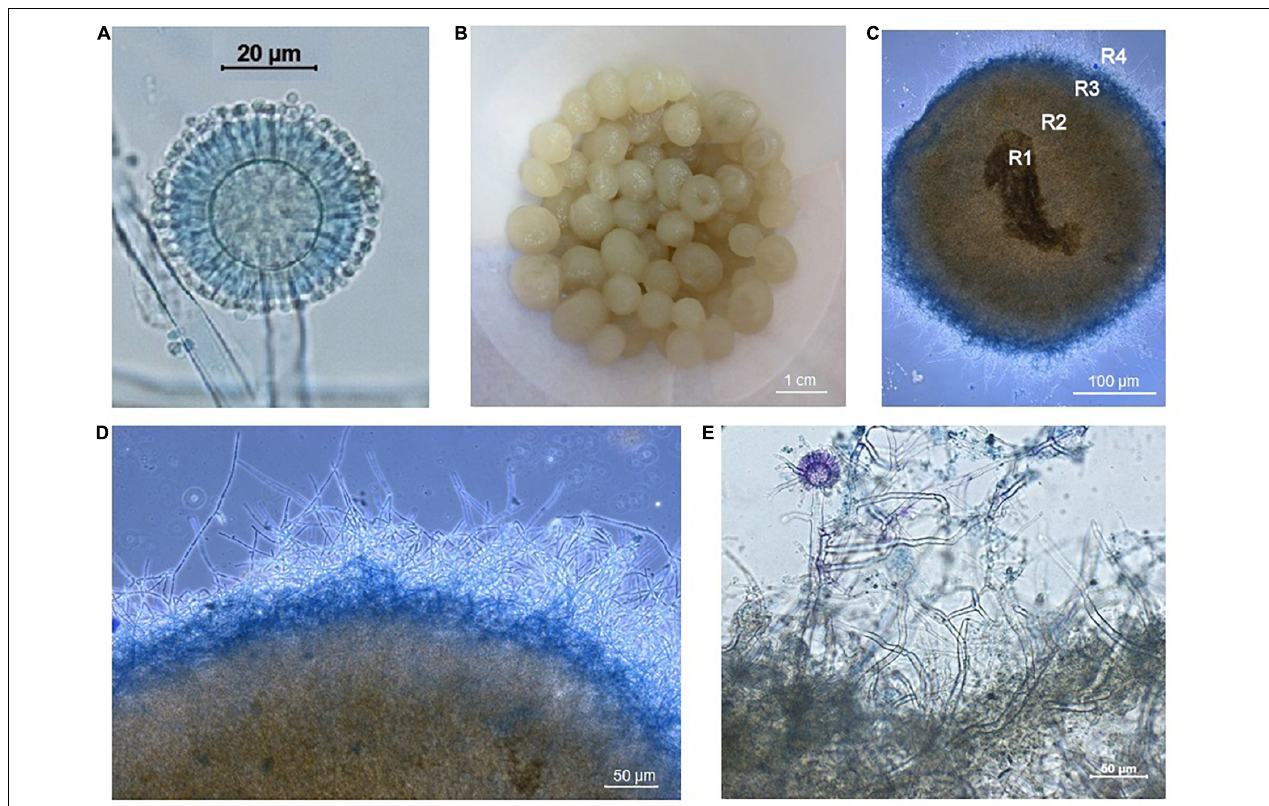
FIGURE 2 | (A) Conidial head of Aspergillus niger (conidiophore terminated by a vesicle with phialides and conidia). (B) Aspergillus niger pellets after washing and filtration. (C) Aspergillus niger pellets, which have four visible parts according to García-Reyes et al. (2017). R1 is the core of the pellet, R2 the hollow part, which may be around the core, R3 is the layer of fibers which may show signs of autolysis, R4 is the outer part of the pellet which appears to be fuzzy or hairy, the so-called “hairy region” and consists of viable fibers. (D) Detail of the “hairy region” of the pellet. (E) Detail of “hairy region” of the pellet with a conidiophore of Aspergillus niger